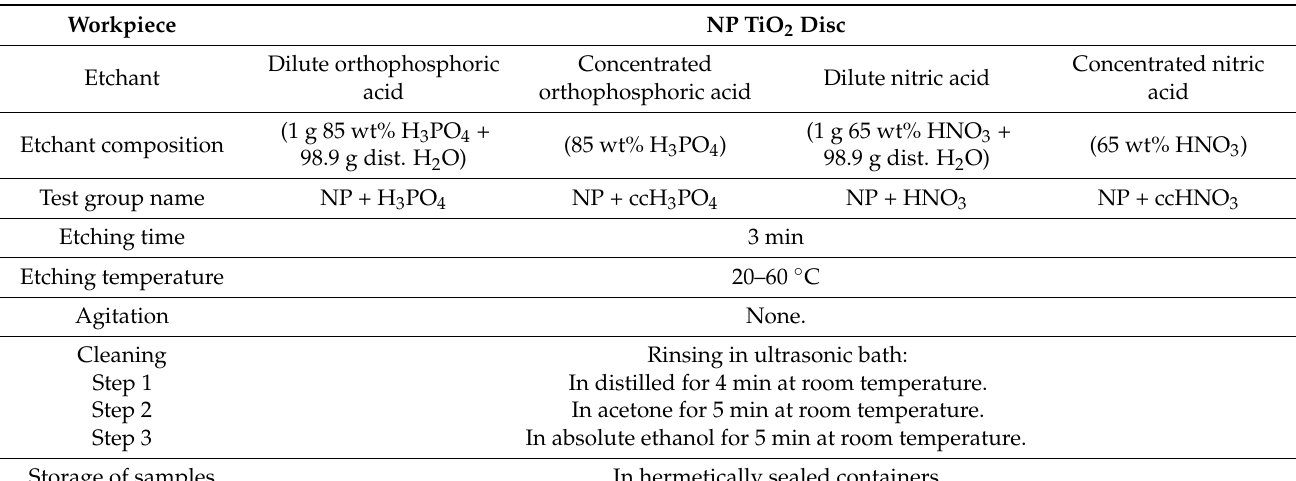
Table 1. The process of sample preparation. Altogether, four test groups were prepared by etching the NP surfaces using various